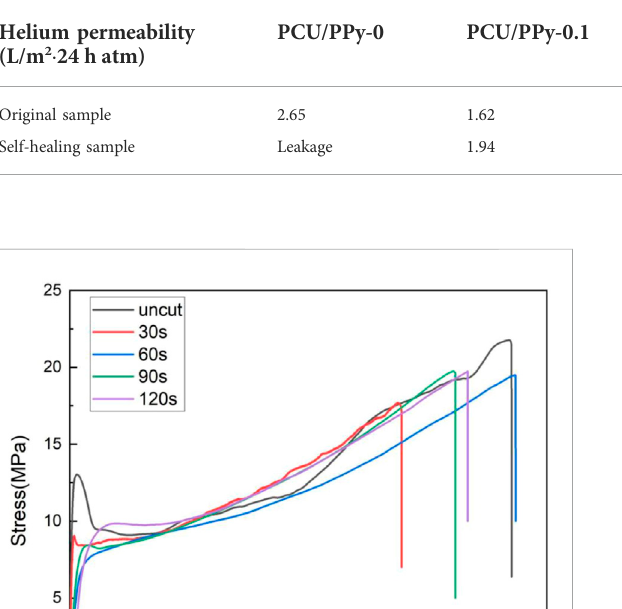
TABLE 2 Helium permeability of PCU/PPy-x before and after self-healing.